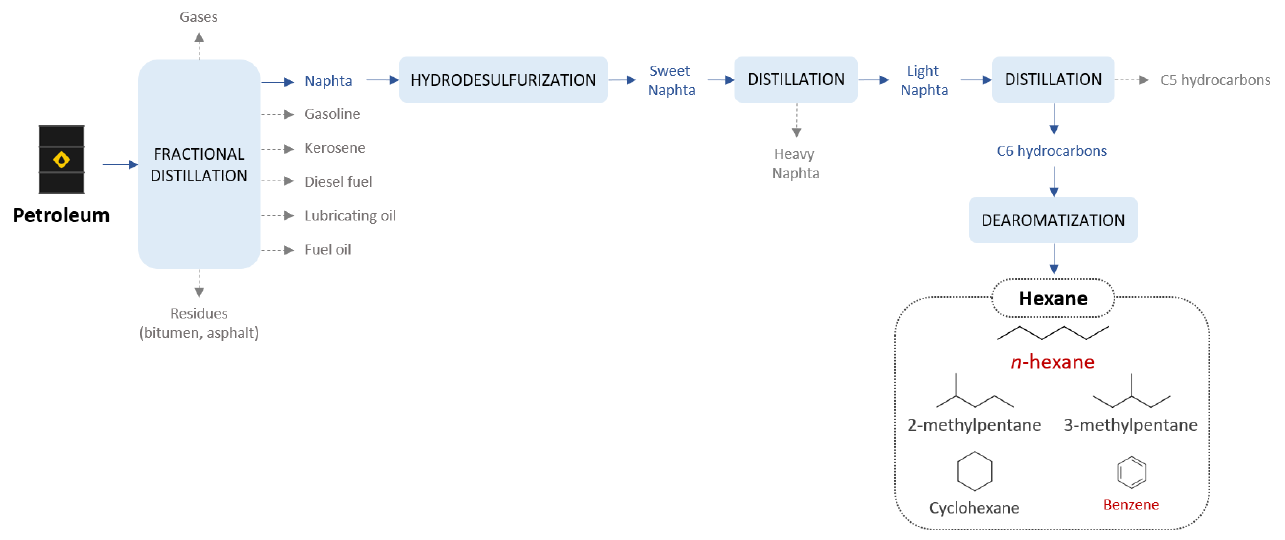
Figure 1. Hexane production and composition.